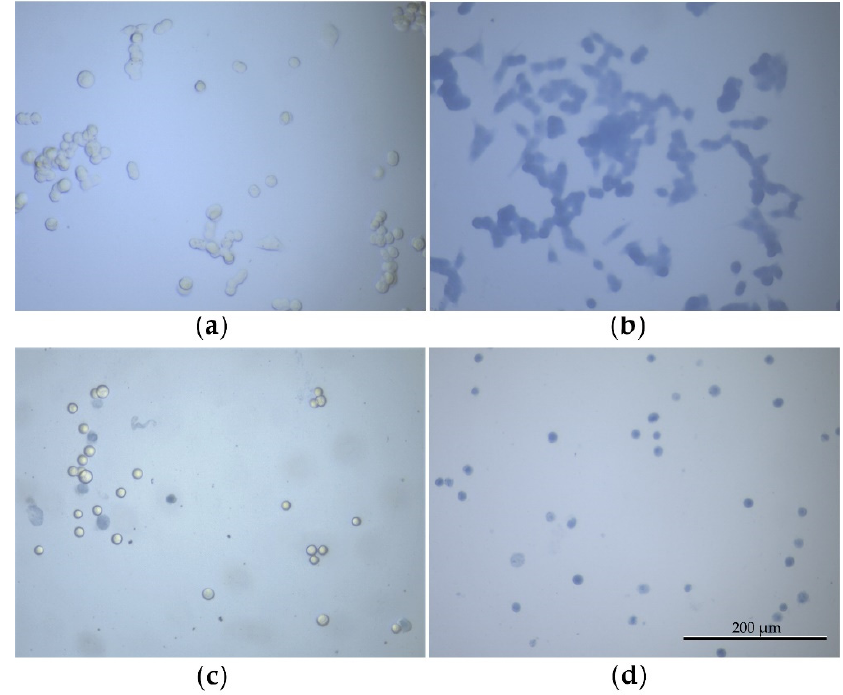
Figure 2. Trypan Blue staining: ( a ) viable cells attached to the glass surface; ( b ) non-viable cells attached to the glass surface; ( c ) suspended viable cells; ( d ) suspended non-viable cells. The images were obtained in the navigation channel of the MIM-340 microscope at × 810 magnification. Scale bar in the figure represents 200 μ m.